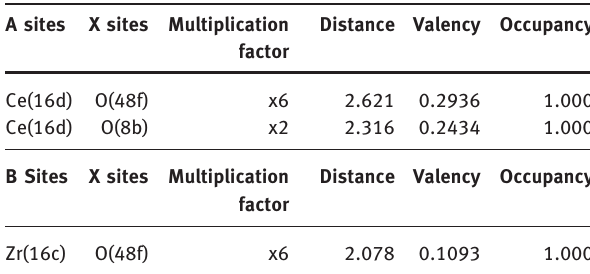
Table 8: Bond distance and valencies